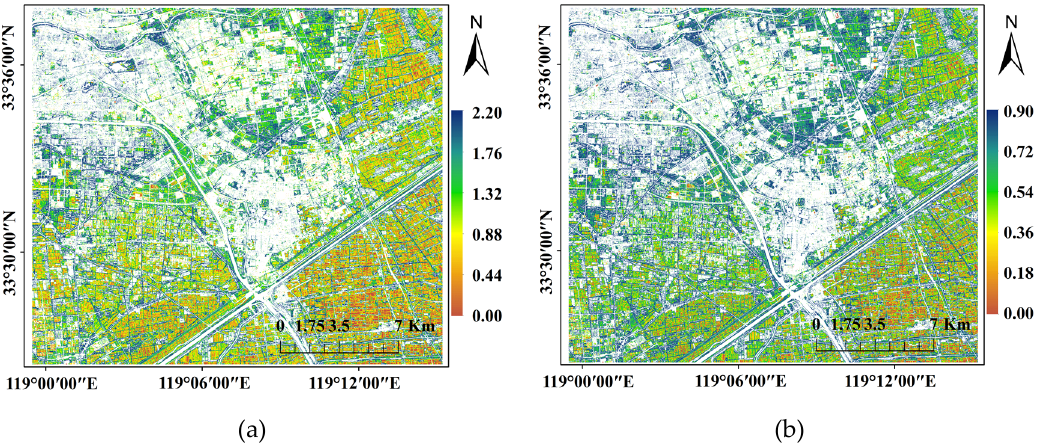
Figure 7. Spatial distribution of ShDI and SiDI of Pléiades data in Case II region in 2018 (( a ) is ShDI, ( b ) is SiDI).